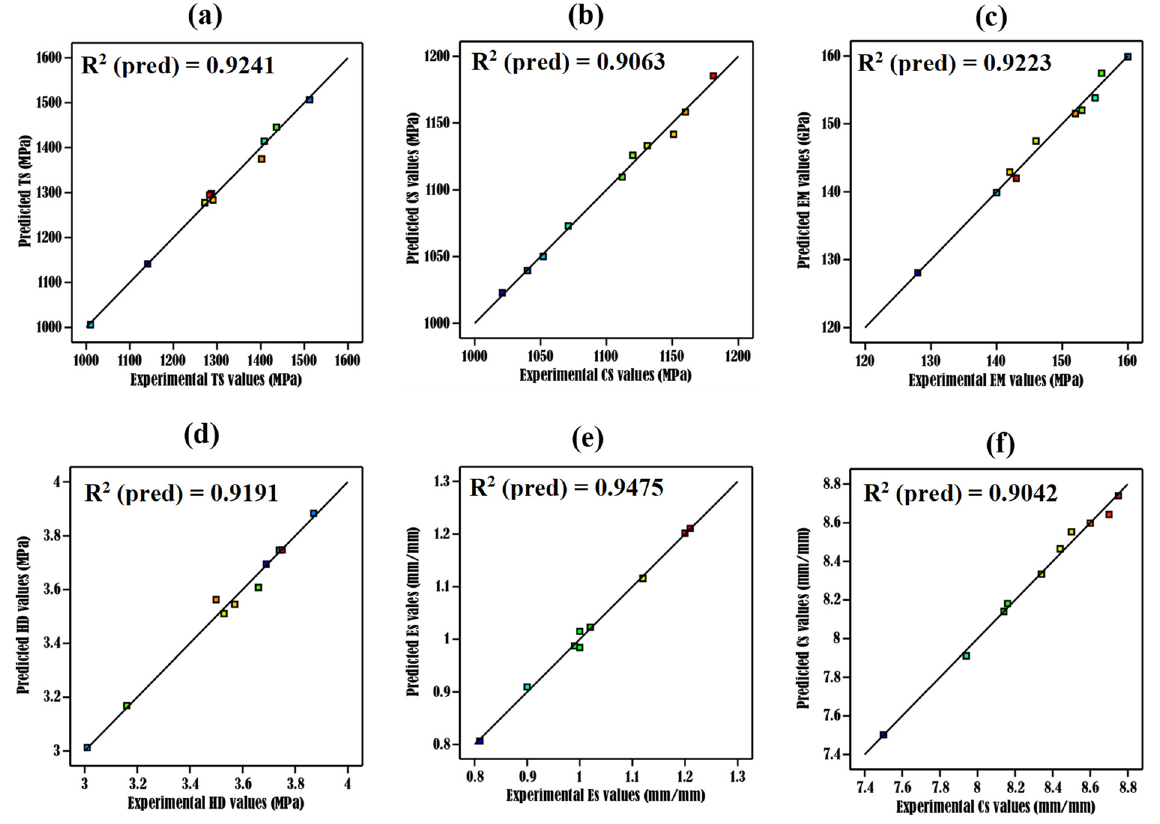
Figure 5. Predicted vs. experimental values plot for the responses.